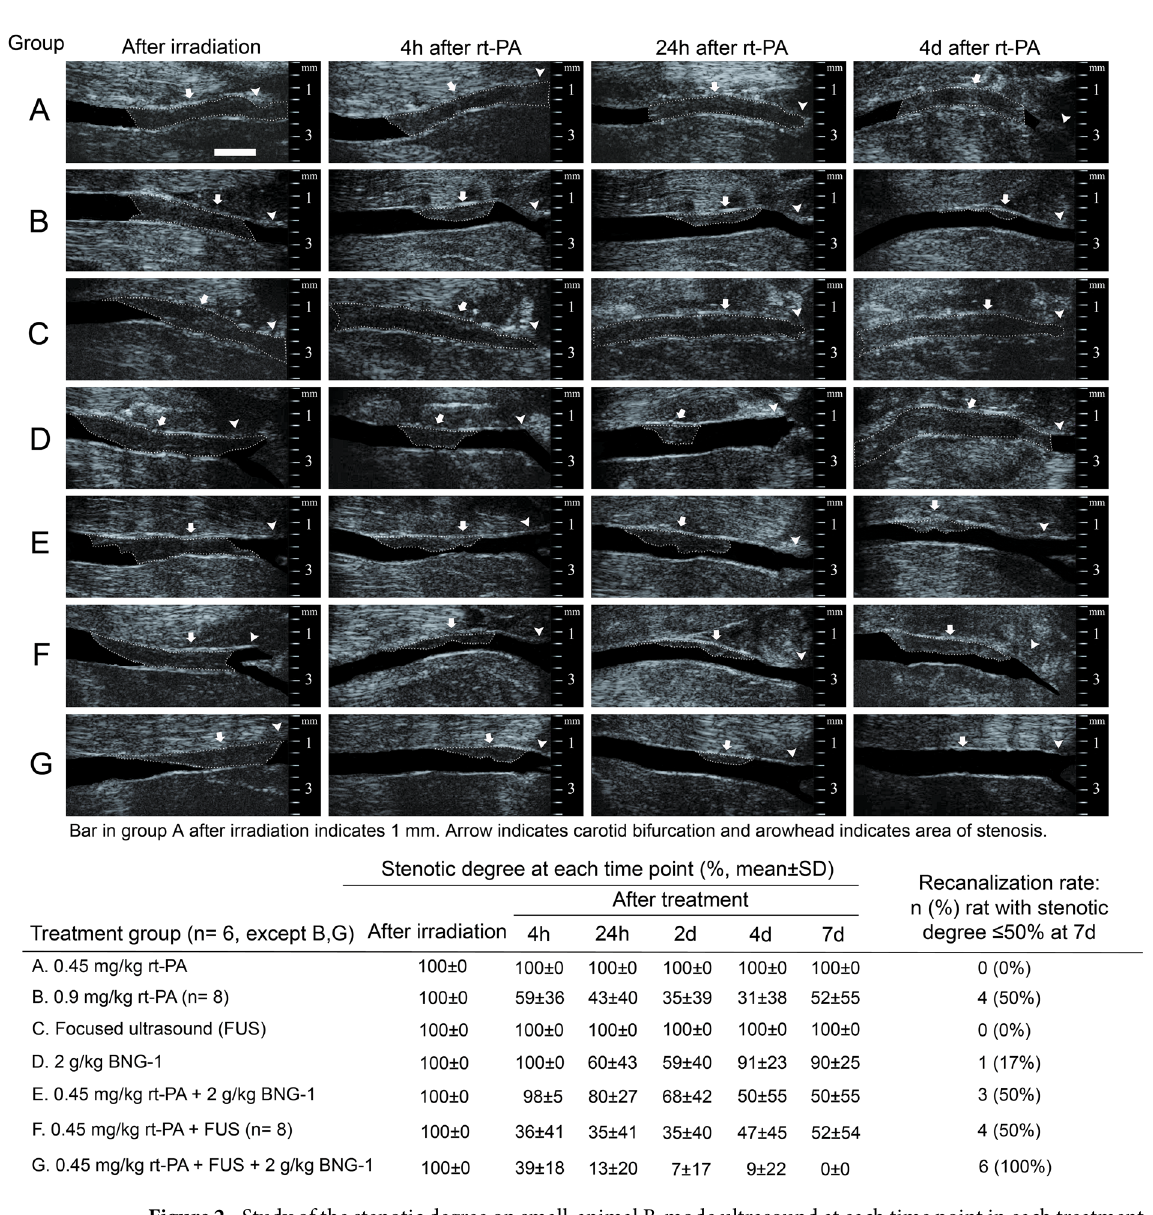
Figure 2. Study of the stenotic degree on small-animal B-mode ultrasound at each time point in each treatment group. Recanalization is found as early as 4 h after rt-PA in groups B, F and G, but improves to 0% stenosis at 7 d only in group G. Groups A and C have persistent occlusion from 4 h to 7 d. Groups D and E have almost complete occlusion at 4 h but recanalize from 24 h with a better recanalization rate in group E at 7